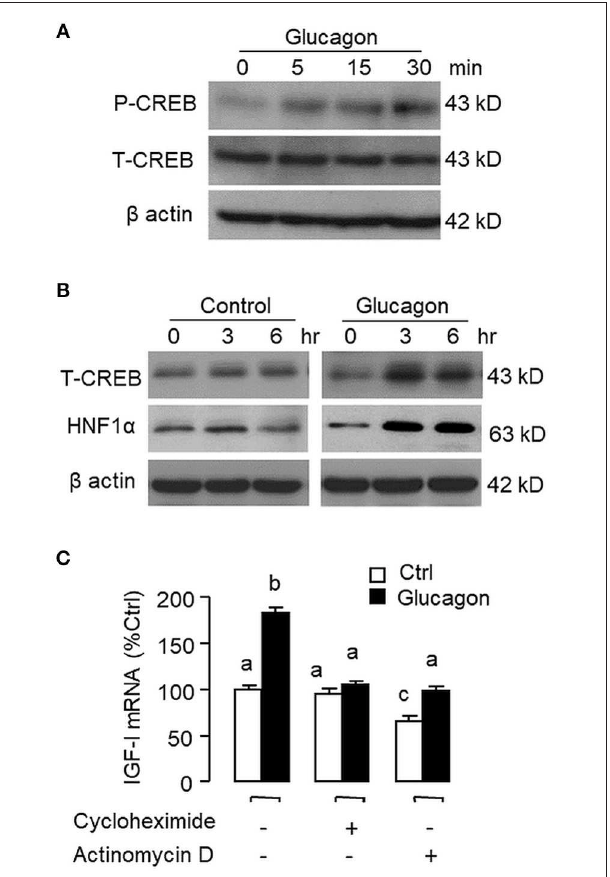
FIGURE 3 | Glucagon-induced HNF1 α and CREB expression in carp hepatocytes and function role of gene transcription and protein synthesis in the corresponding responses for IGF-I transcript. (A) Short-term treatment of glucagon (10nM, up to 30min) on CREB phosphorylation. (B) Long-term treatment of glucagon (10nM, up to 6h) on HNF1 α and CREB protein expression. In these experiments, cell lysate was prepared from carp hepatocytes after drug treatment at the time points as indicated and subjected to Western blot using antibodies for phosphorylated CREB (as “P-CREB”) and total protein for CREB (as “T-CREB”) and HNF1 α , respectively. Parallel blotting for β actin was also conducted to serve as the internal control. (C) Blocking gene transcription and protein synthesis on glucagon-induced IGF-I mRNA expression. Hepatocytes were challenged with glucagon (10nM) for 12h in the presence of the transcriptional inhibitor actinomycin D (8 µ M) or protein synthesis inhibitor cycloheximide (10 µ g/ml). After drug treatment, total RNA was isolated from individual wells and used for real-time PCR with primers specific for IGF-I